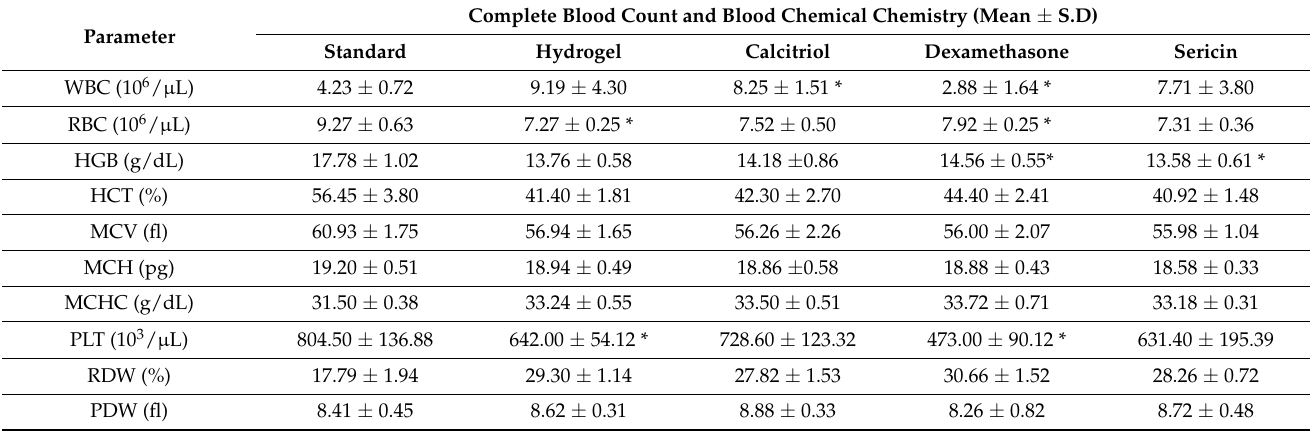
Figure 5. Psoriatic gene expression levels in a rat model. ( A ) Bar graph of relative mRNA FLG expression levels in rat skin specimens. ( B ) Bar graph of relative mRNA caspase-14 expression levels in rat skin specimens. ( C ) Bar graph of relative mRNA S100a7a expression levels in rat skin specimens. ( D ) Bar graph of relative mRNA S100a14 expression levels in rat skin specimens. The significant level in the figure was presented as * = p < 0.05. Table 1. Complete blood count and chemical chemistry (mean ±